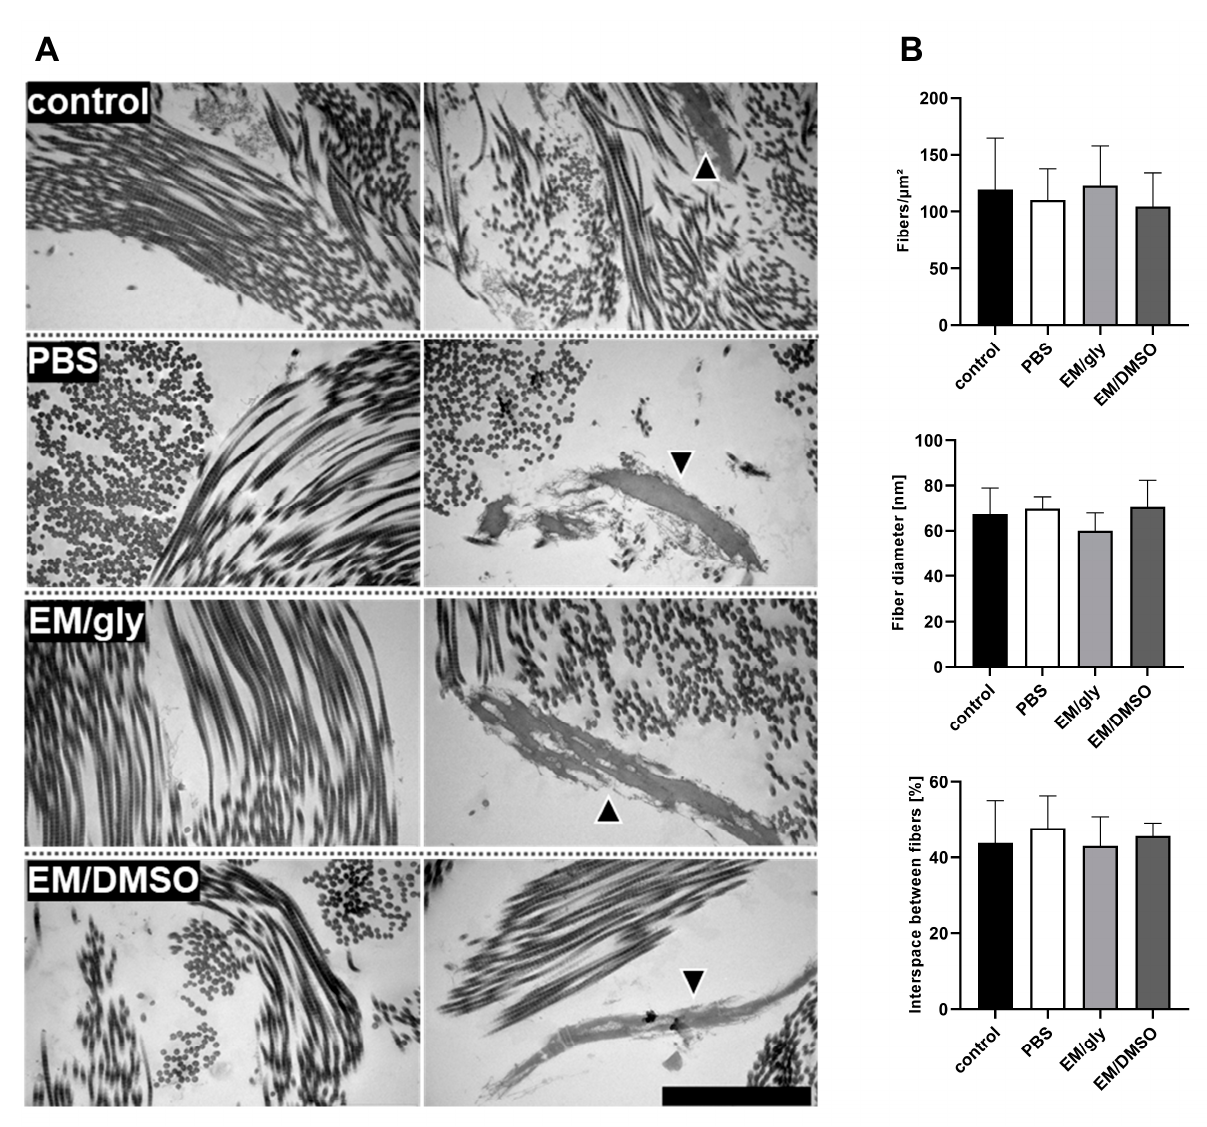
Figure 2. ( A ) Representative TEM images of fresh PDC (control) and PDC stored for six months in PBS (at 4 ◦ C), in EM/gly (at − 80 ◦ C) and in EM/DMSO (at − 196 ◦ C). The left column shows collagen fibers in longitudinal and cross-sections, and the right column shows images with elastin fibers (arrowheads); scale = 2 µ m, n = 3. ( B ) Results of the quantitative analysis of the number of collagen fibers per µ m 2 , the fiber diameter, and the space between the fibers.